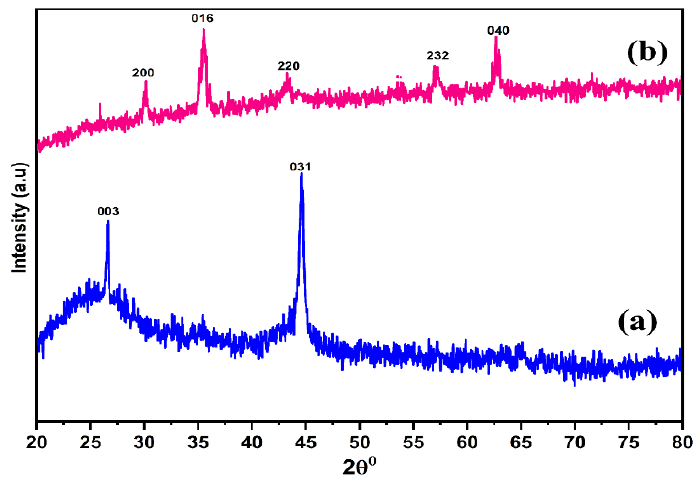
Figure 5. X-ray diffraction (XRD) patterns of NBC (a) and MBC (b).